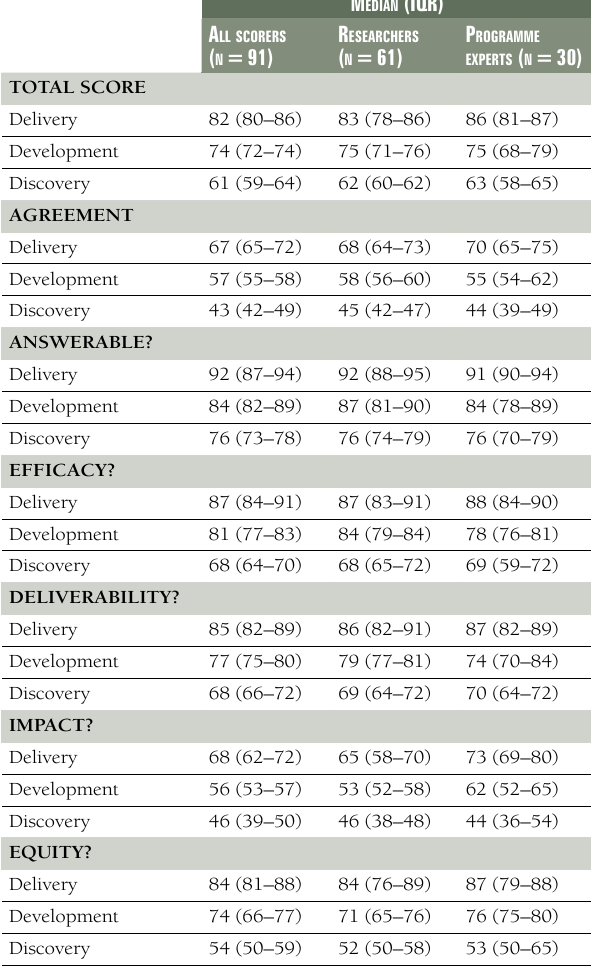
Table 4. Overall scoring pattern by profile of